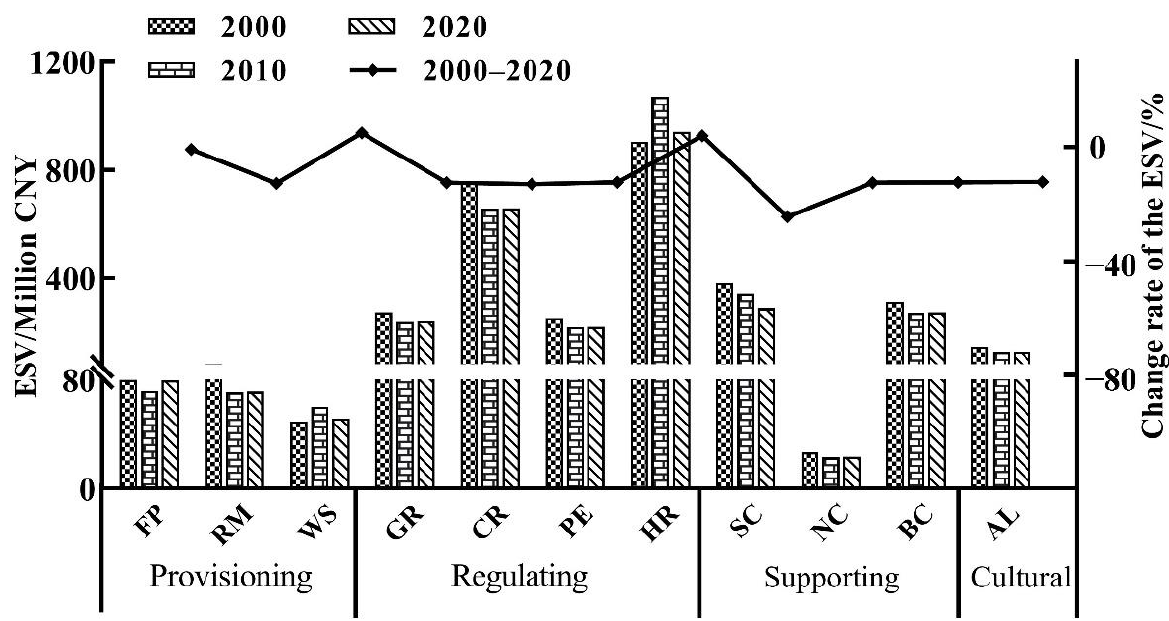
Figure 7. Value of individual ES and their change rate from 2000 to 2020. (The bar chart represents the value of individual ecosystem service, and the line chart represents their change rate from 2000 to 2020).